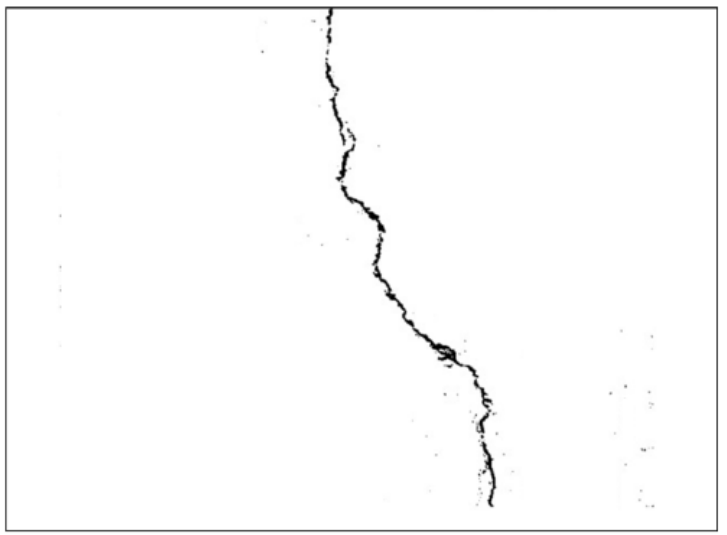
Figure 11. Sample results after the different image processing and noise reduction iteration.